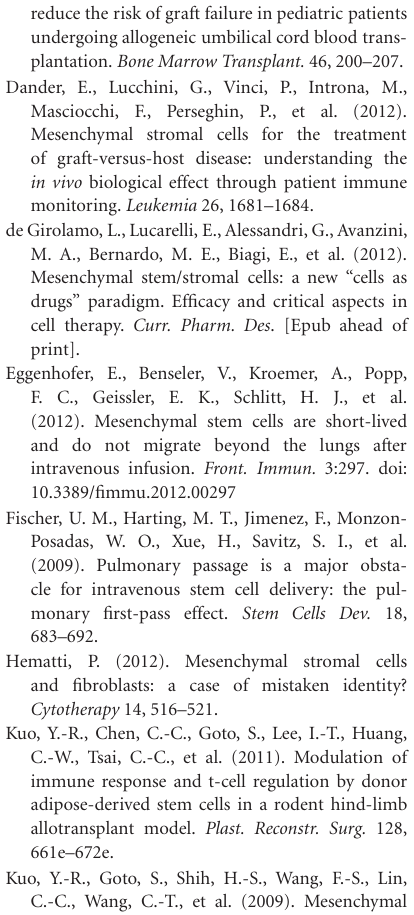
FIGURE 1 | (A) Fluorescent MSC (yellow) after perivascular homing to critically ischemic skin. 3D reconstruction from Laser-Scanning Confocal Microscopy. (B) Fluorescent MSCs (green) 14 days after tailvein injection and homing to critically ischemic skin. (Freshly isolated BM-MSC; tail vein injection).